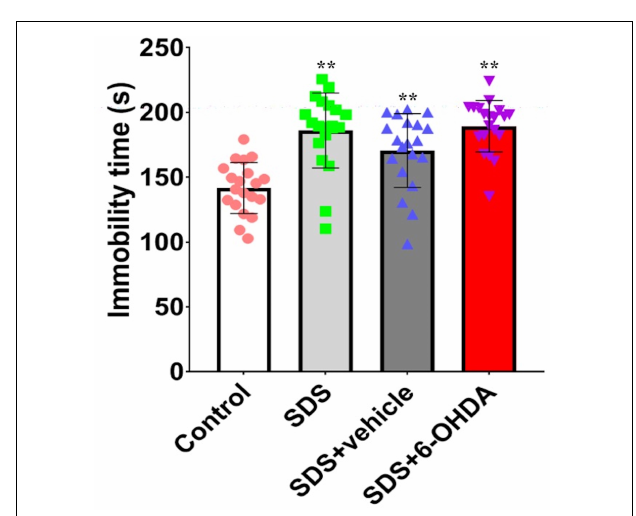
FIGURE 8 | Effects of social defeat stress on the recognition index in the 6-OHDA lesioned mice. * p < 0.05, ** p < 0.01, compared with the control group ( n = 20 per group).